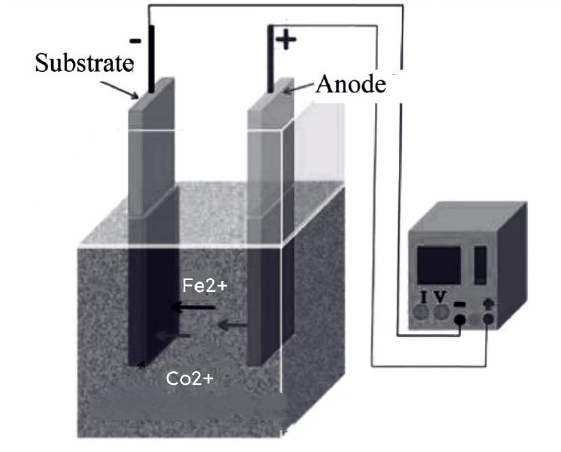
Figure 1. Schematic diagram of the Fe-Co electrodeposition process.